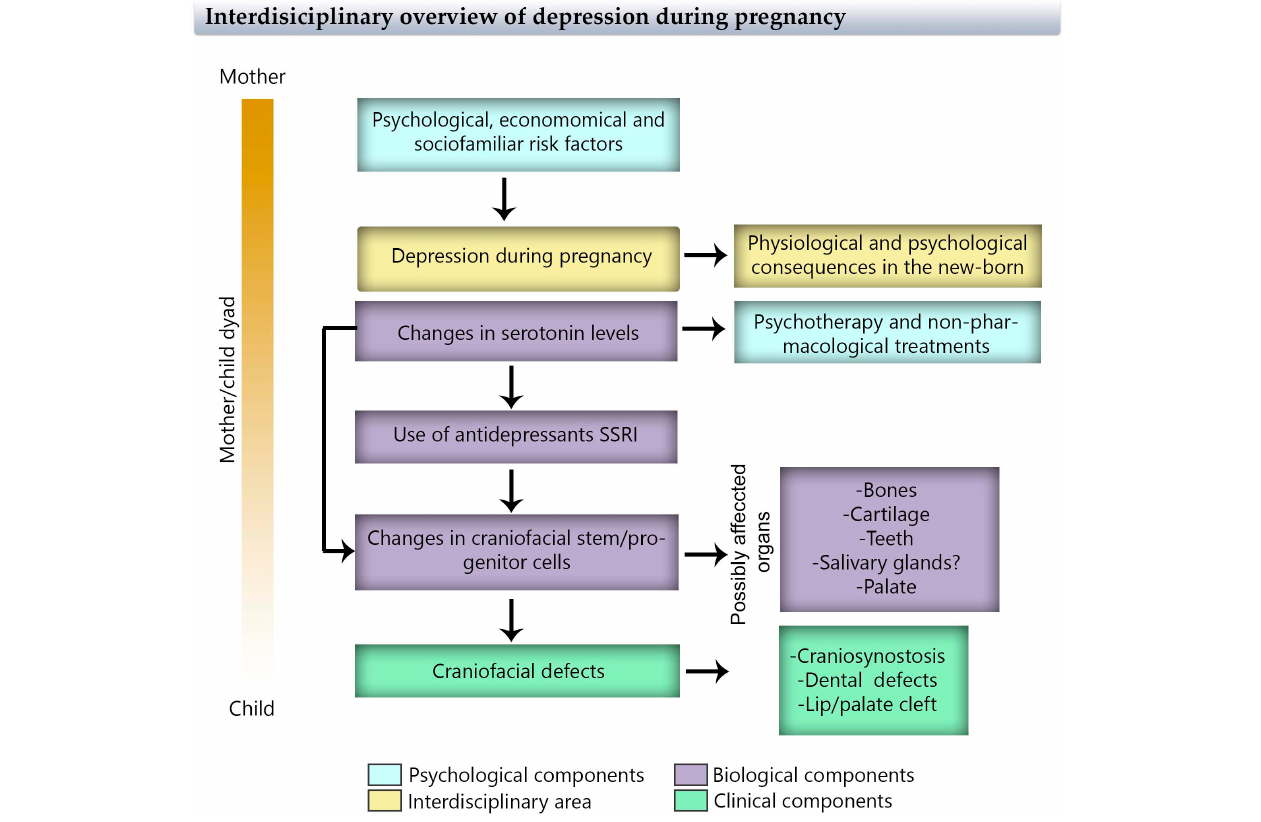
FIGURE 5 | Flowchart of maternal depression during pregnancy through an interdisciplinary view considering psychological, physiological, biological, and clinical components that affect the mother/child dyad.